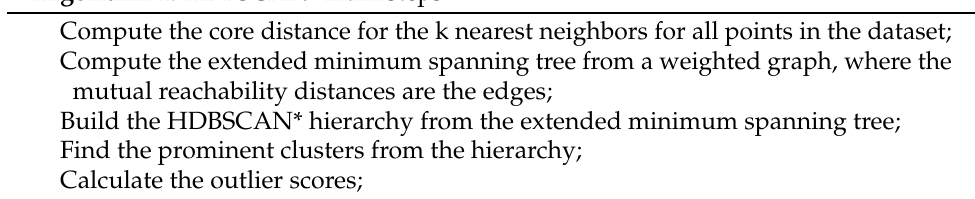
Algorithm 1: HDBSCAN* main